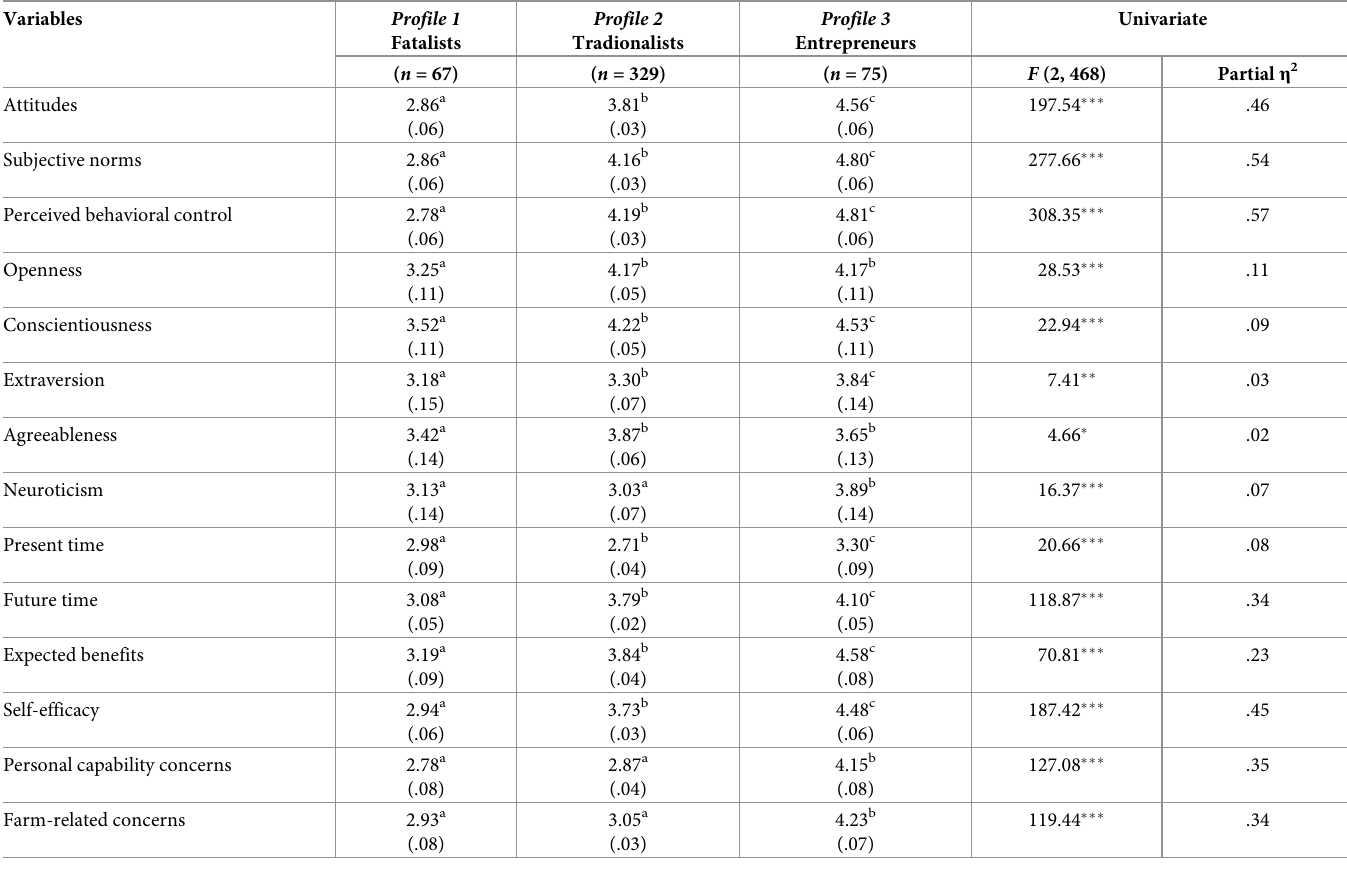
Table 4. Means, standard errors and mean differences across three beef farmer